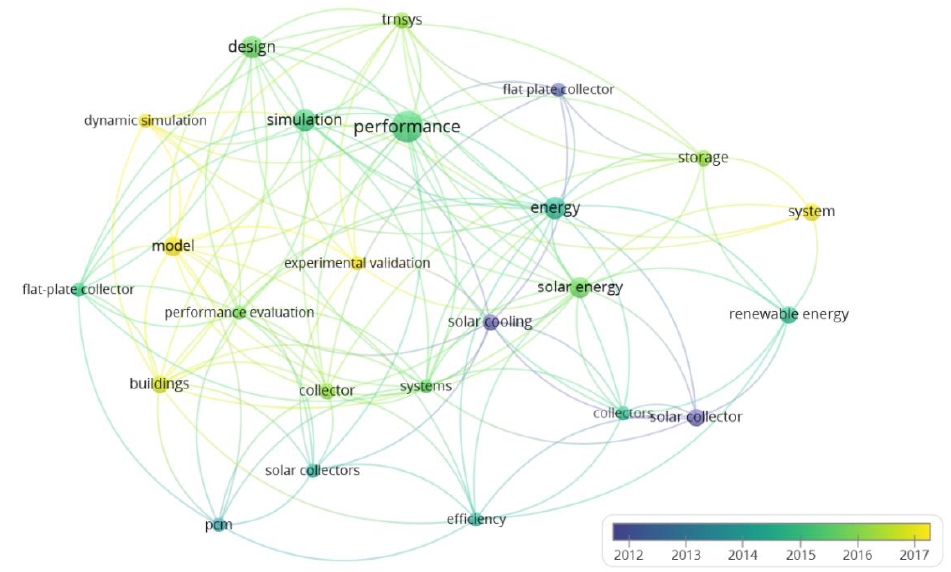
Figure 6. Main co-occurrences of keywords in the analyzed sample.